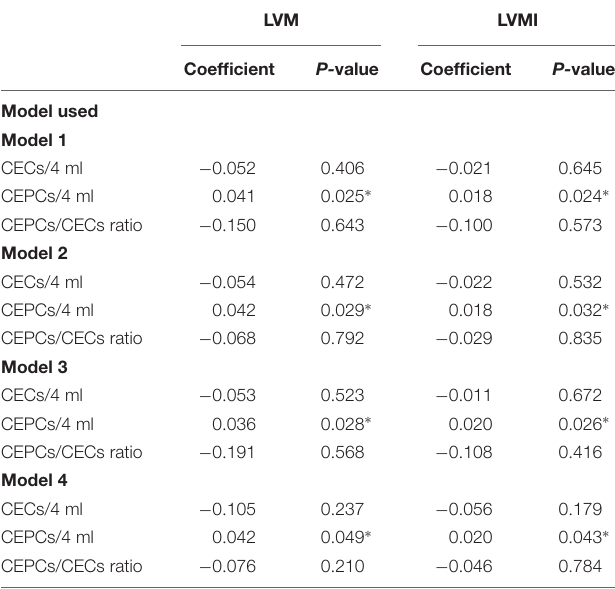
TABLE 6 | Multivariate analysis of relationship between indicators of left ventricular function and endothelial